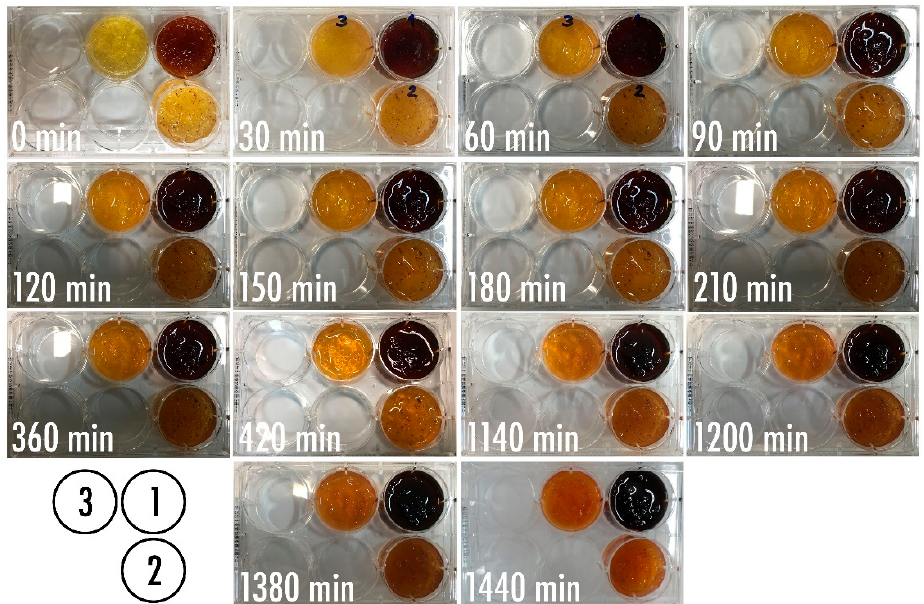
Figure 7. Results obtained in the optimization of the amounts of phage particles, sodium 1,2- naftoquinone-4-sulfonate, gelatin, and casein, leading to the bio-reactive chromogel for bio-detection system I, displaying the time evolution of the color produced using a fixed (added) amount of P. aeruginosa cells. The composition of formulations 1, 2, and 3 is displayed in Table 1. Using the freely available, open source, image processing software ImageJ (Fiji, vs. 2.0.0-rc-68/1.52e) from the National Institute of Health (USA), the surface area of each chromogel in Figure 7 was analyzed pertaining to its integrated color density, and the results duly normalized by the integrated density of the chromogels for the last reaction time assayed (Figure 8). Figure 8. Normalized integrated color density of the three chromogels containing phage particles, sodium 1,2-naftoquinone-4-sulfonate, gelatin, and casein, further contacted with a fixed amount of P. aeruginosa cells, throughout the bioreaction time, allowing us to select an optimized bio-reactive chromogel. Values represent the mean of three independent assays. Error bars represent the stand- ard deviation.